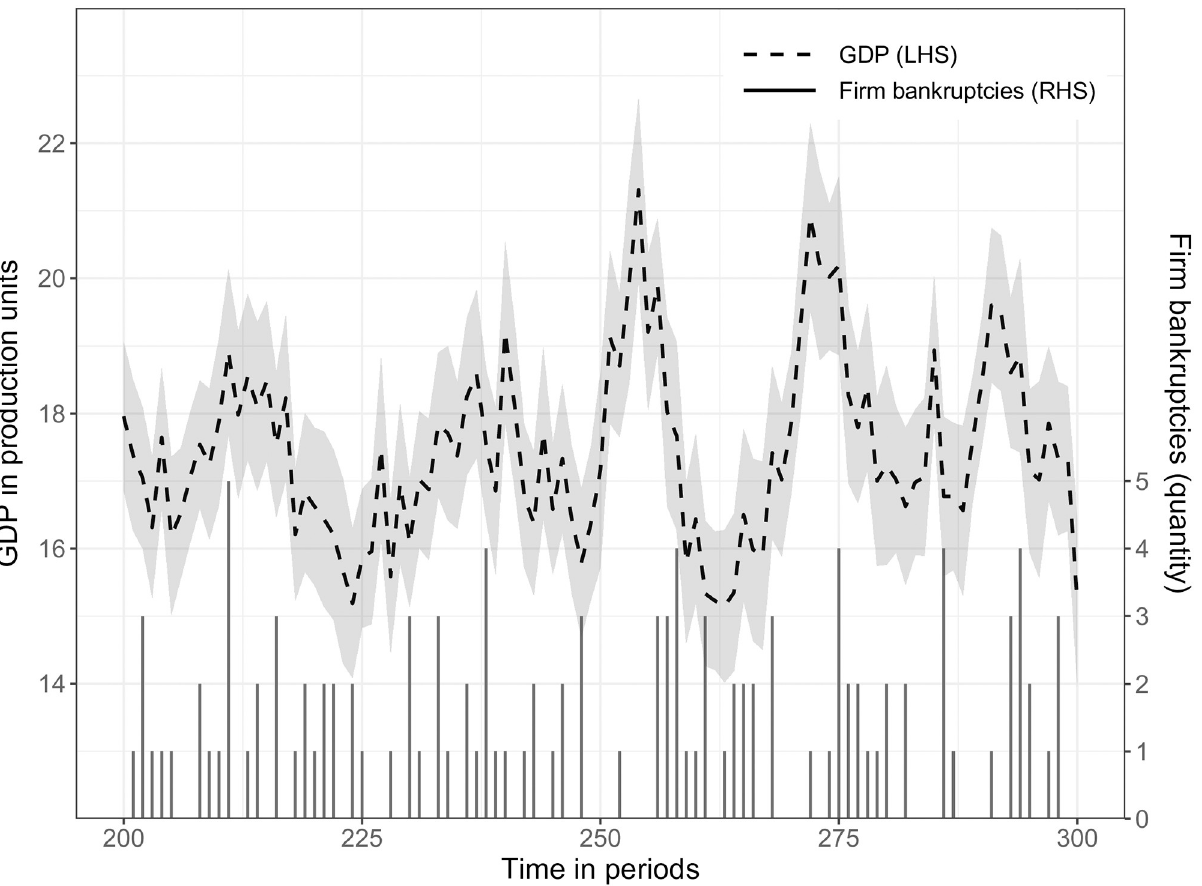
Fig 11. SF10: Real GDP and firm bankruptcies time series. Note: The Figure depicts average real GDP as a dashed line and firm bankruptcies as a solid line in bars. The simulation output is a representative run and shows an extract to keep the line profile more identifiable without the warm-up phase of 200 simulation periods. The grey shaded area represents the 90% confidence